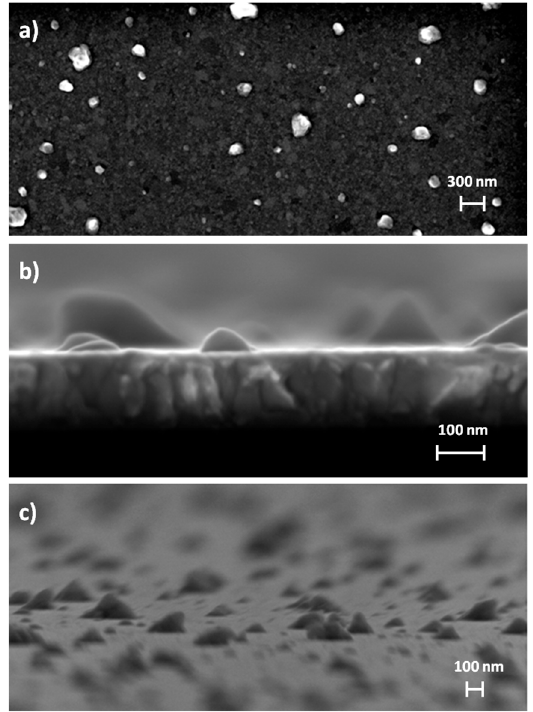
Figure 6. FESEM images of the resistor: ( a ) top view; ( b ) cross-section view and ( c ) tilted view.